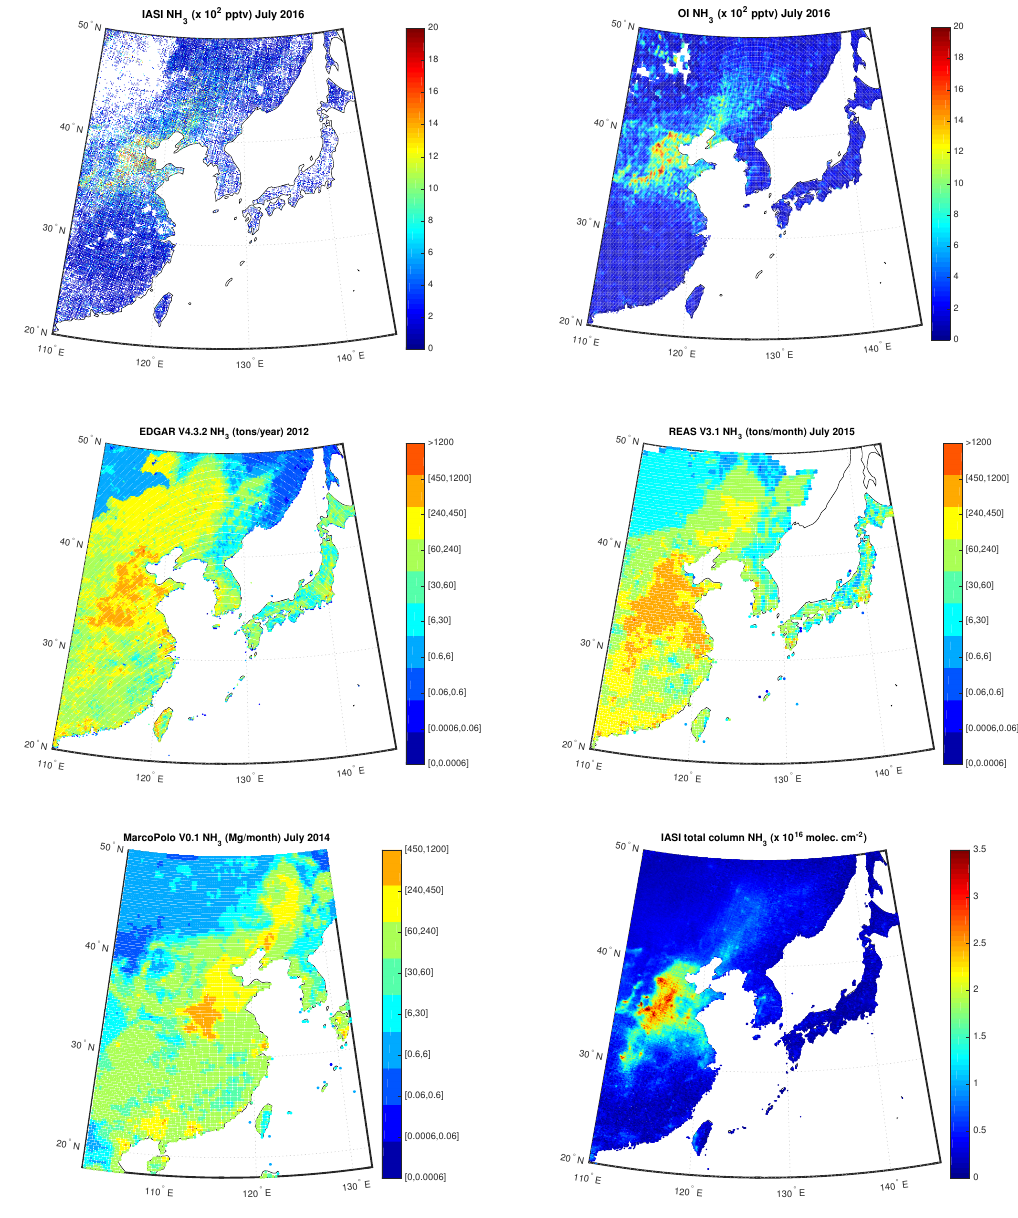
Figure 17. First row: IASI and OI NH 3 over China for the month July 2016; Second Row: EDGAR V4.3.2 NH 3 for the year 2012 and REAS V3.1 NH 3 for the month of July 2015; Third Row: MarcoPolo v0.1 NH 3 for the month of July 2014 and total column of nine-years global IASI average NH 3